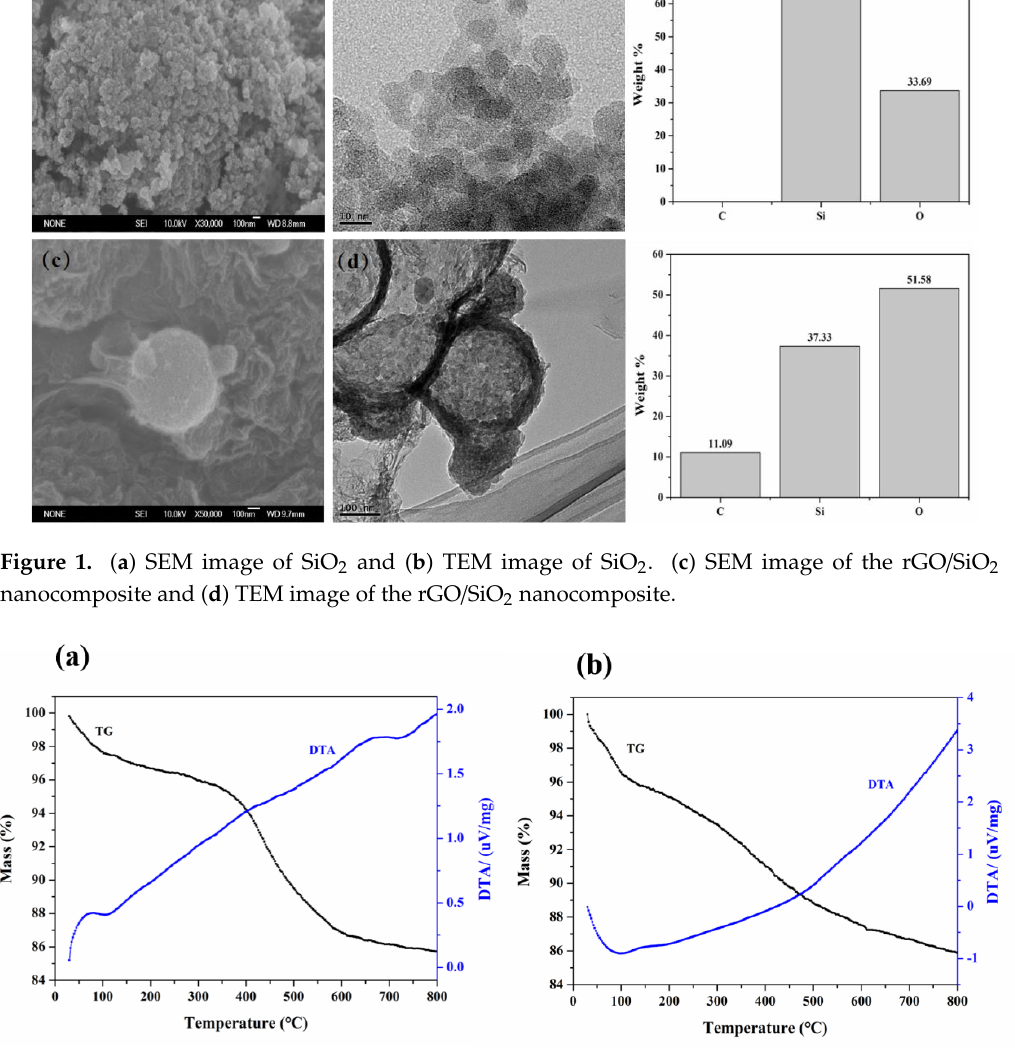
Figure 1. ( a ) SEM image of SiO 2 and ( b ) TEM image of SiO 2 . ( c ) SEM image of the rGO/SiO 2 nanocomposite and ( d ) TEM image of the rGO/SiO 2 nanocomposite.